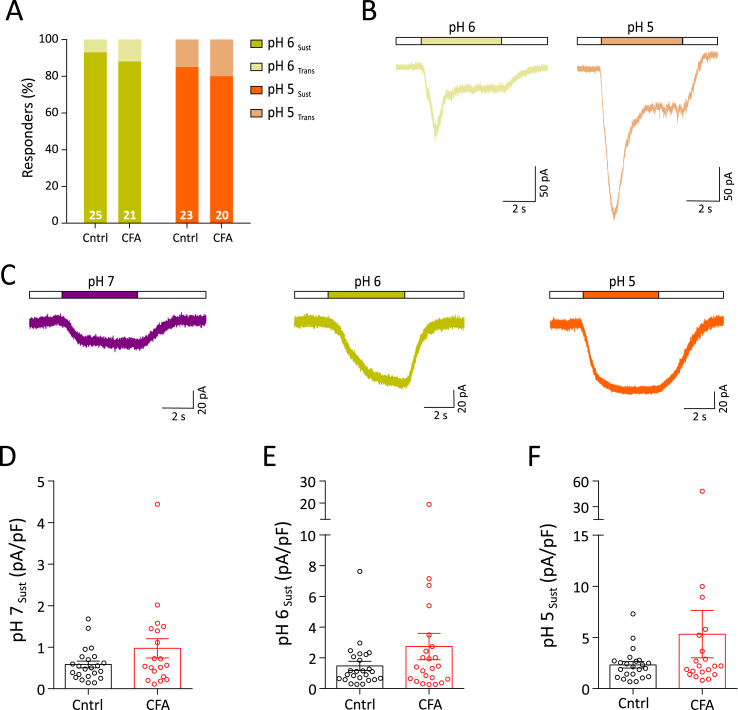
Acid sensitivity of knee neurons after acute inflammation. A) Percentage frequency of transient + sustained vs. sustained only response to pH 6 (transient + sustained, light yellow; sustained, dark yellow) and pH 5 (transient + sustained, light orange; sustained, orange) B) Example traces of transient + sustained acid currents in response to pH 6 (light yellow) and pH 5 (light orange). C) Example traces of sustained response to pH 7 (purple), pH 6 (dark yellow) and pH 5 (orange). D-F) Peak current density of sustained pH 7, pH 6 and pH 5 responses (CFA: red dots, Cntrl: black dots). (For interpretation of the references to colour in this figure legend, the reader is referred to the Web version of this article.)